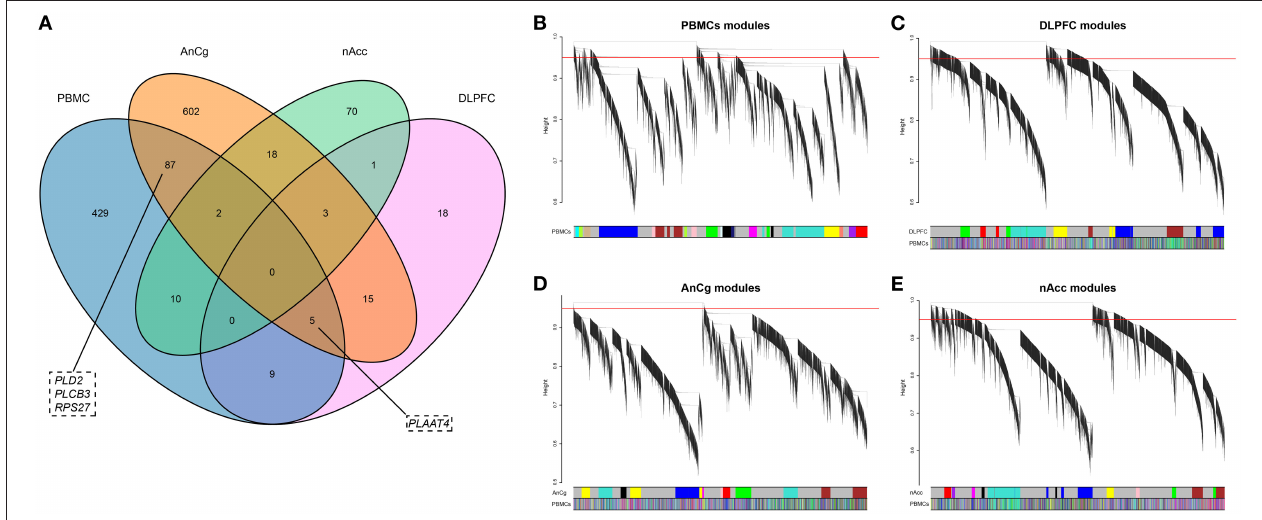
FIGURE 2 | (A) The Venn diagram of the DEGs in PBMCs, DLPFC, AnCg, and nAcc. (B–E) Hierarchical clustering plots for these four data sets. The y-axis represents the network distance with values closer to zero illustrating greater similarity of gene expression, and the x-axis represents the gene modules in each data set. The PBMC module colors are mapped to each brain tissue module with the PBMC color panel denoting the degree of similarity.